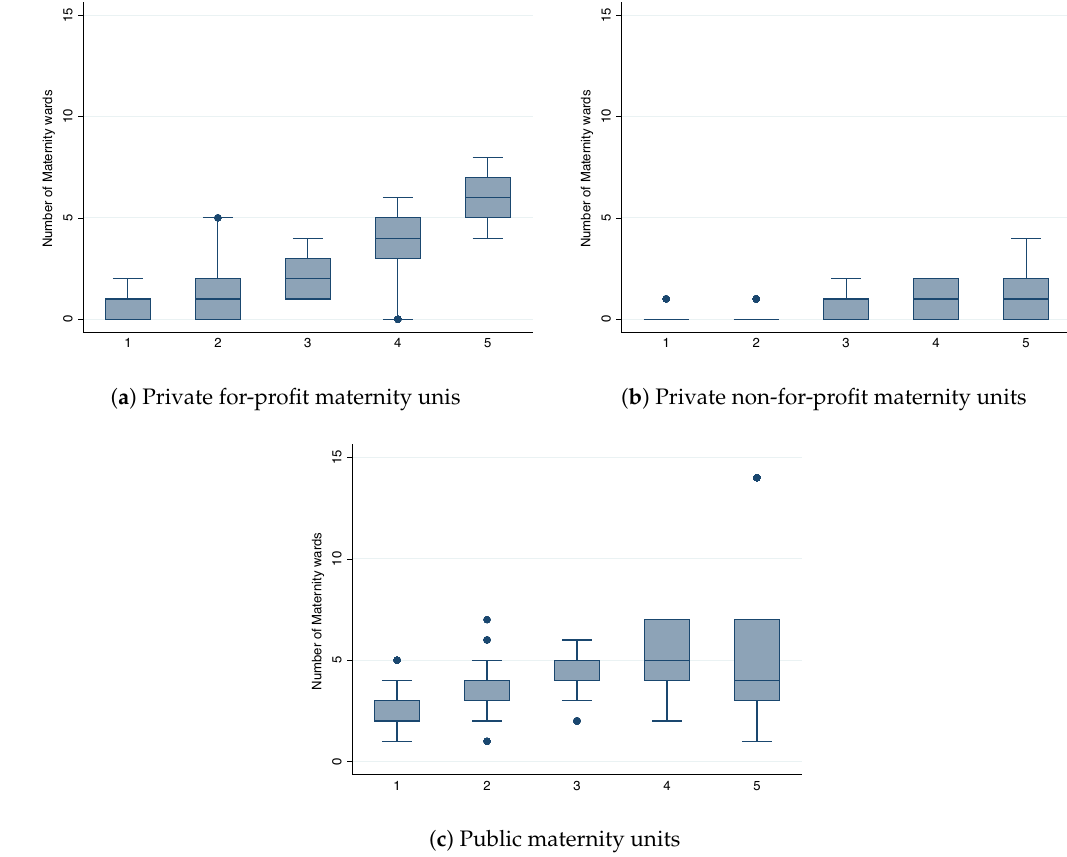
Figure 1. Number of maternity units, by birth quantile.